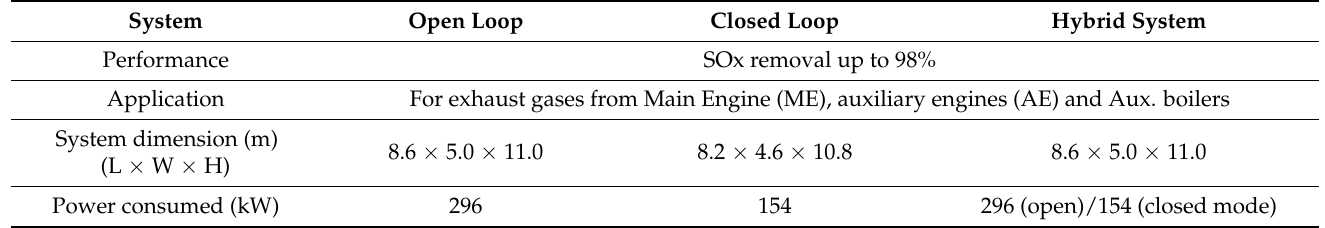
Table 2. Specification of SOx scrubber systems for the case ship (with 25 MW engine) [11].